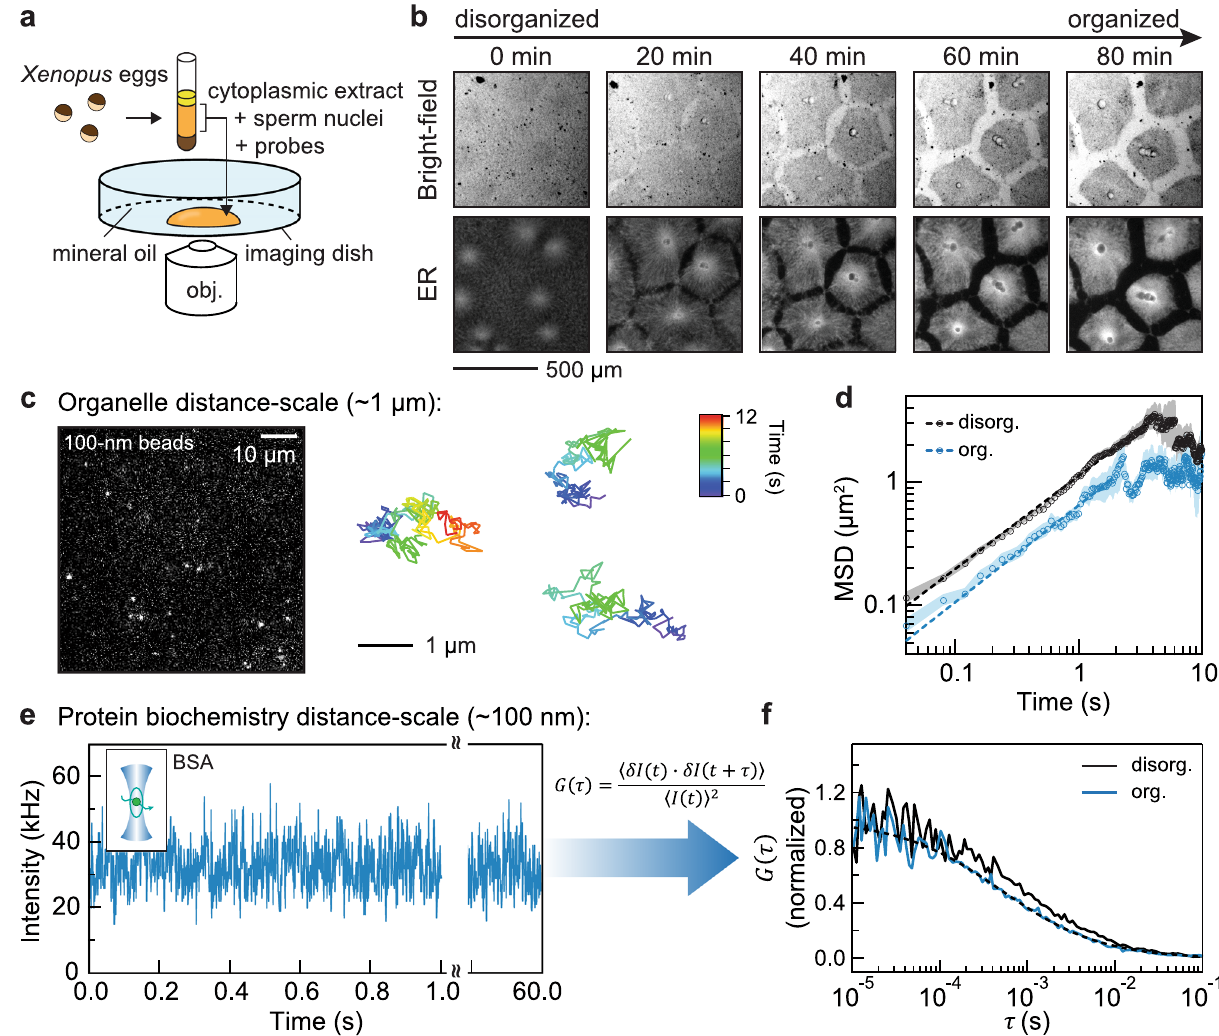
Fig.1|Resolvingmoleculardiffusionincytoplasmicextracts.a Schematicofthe experimental setup used in this study: Xenopus laevis eggs were fractionated